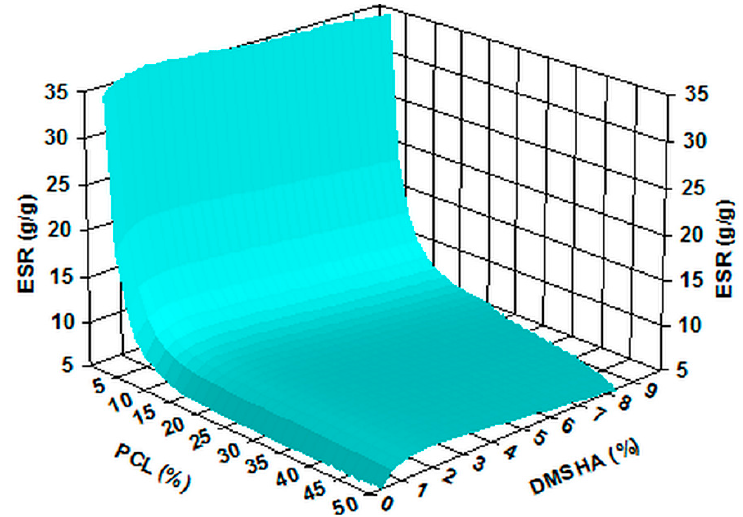
Figure 1. Three-dimensional representation of the investigated specimens’ swelling behaviour as a function of composition.